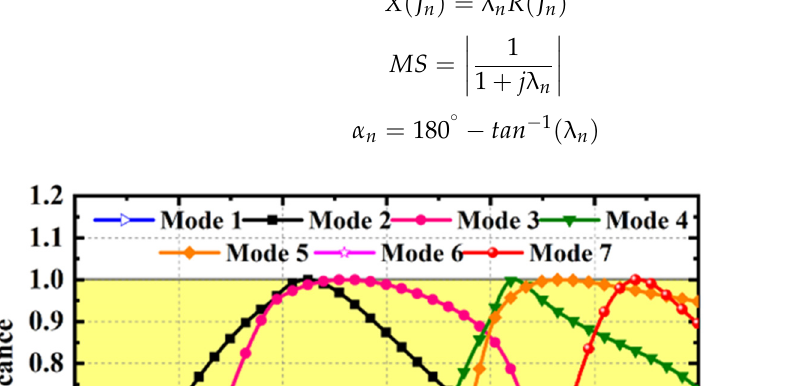
( d ) Figure 6. Two–element MIMO antenna polar radiation pattern representation; ( a ) 3.5 GHz; ( b ) 4.0 GHz; ( c ) 4.5 GHz; and ( d ) 5.5 GHz. 2.4. Eight-Element MIMO Antenna Design and Analysis The design of eight-element MIMO antenna of size 72 × 72 mm 2 is depicted in Figure 7. The basic reason for extending two-element to eight-element is to enhance the capacity and data rate of the wireless devices. In the proposed design, all the two-element antennas are orthogonally spaced to enhance the isolation between the antenna ports. Furthermore, four triangle-shaped slots are etched at the center of the dielectric substrate to enhance the